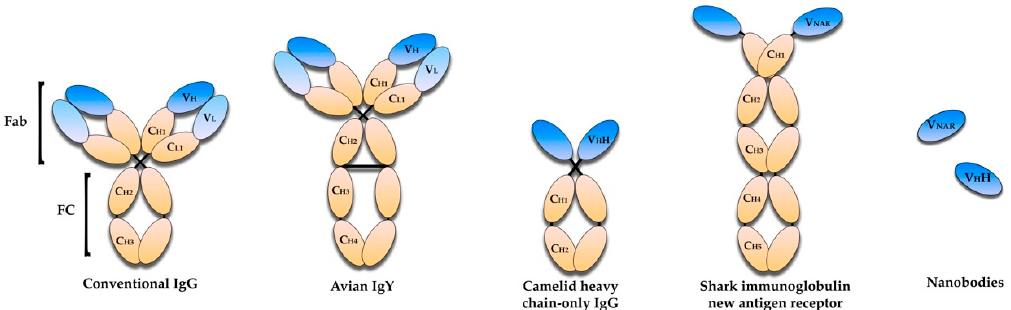
Figure 2. Domain structures of conventional mammalian tetrameric IgG, avian IgY, camelid heavy chain-only IgG (HCAb), shark immunoglobulin new antigen receptor (IgNAR), and nanobodies derived from HCAb and IgNAR. The variable domains are represented in blue and the constant domains are represented in yellow. The VHH and VNAR domains are stable and able to recognize antigens in the absence of the heavy chain.